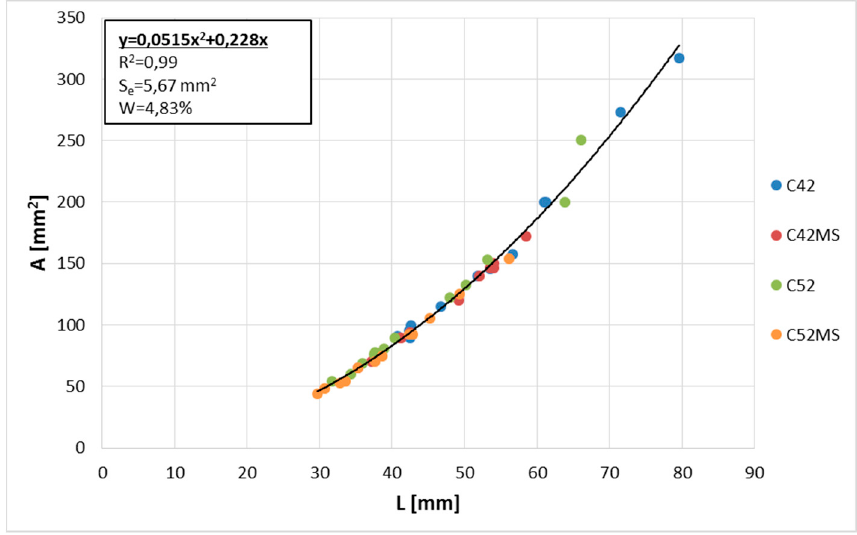
Figure 4. Cluster average area ( (cid:1827)̅ ) as a function of cluster average perimeter ( (cid:1838)(cid:3364) ). Table 4. Equations of curves describing the (cid:1827)̅(cid:4666)(cid:1835)̅) relationship, together with values of diagnostic statistics ( R 2 , S e , W ) and the correlations coefficients ( ρ ).